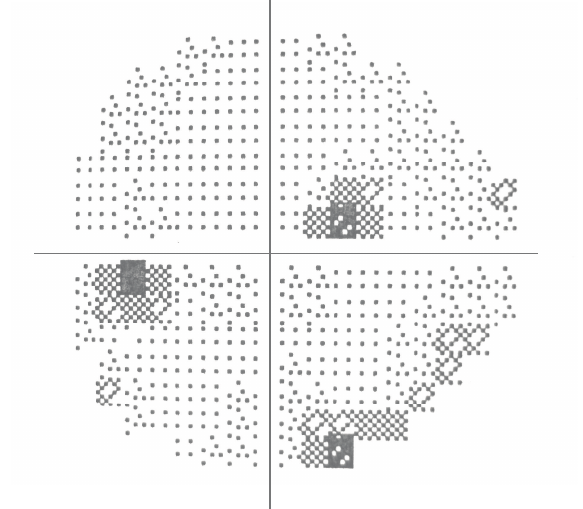
Figure 5: Visual field of the LE 20 months after successful embolism (V/A